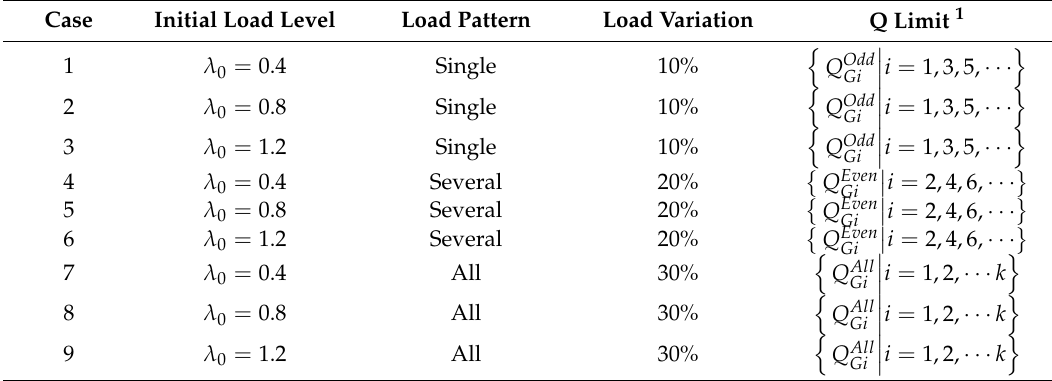
Table 1. Selected cases for the studied system.